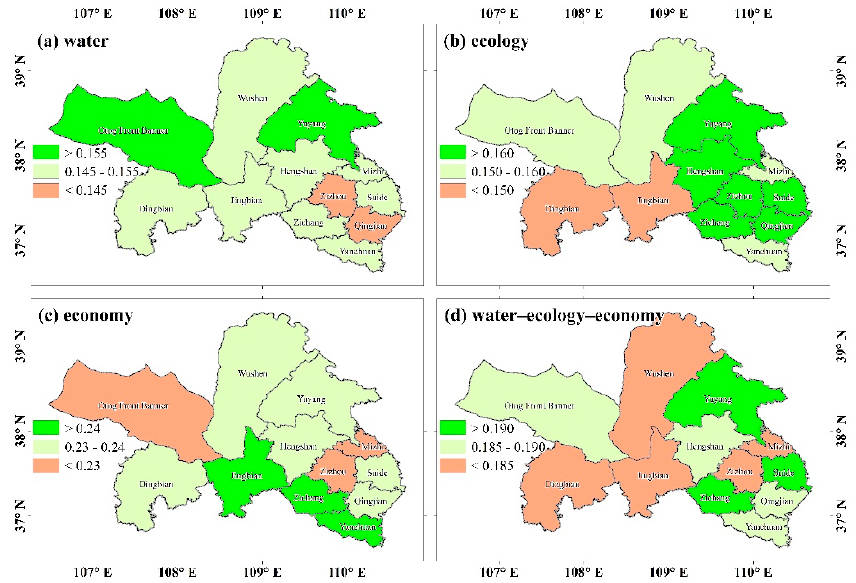
Figure 4. Spatial patterns of mean value of ( a ) water, ( b ) ecology and ( c ) economy subsystem evaluation indices and ( d ) their comprehensive indices, respectively in the Wuding River watershed between 2001 and 2020.